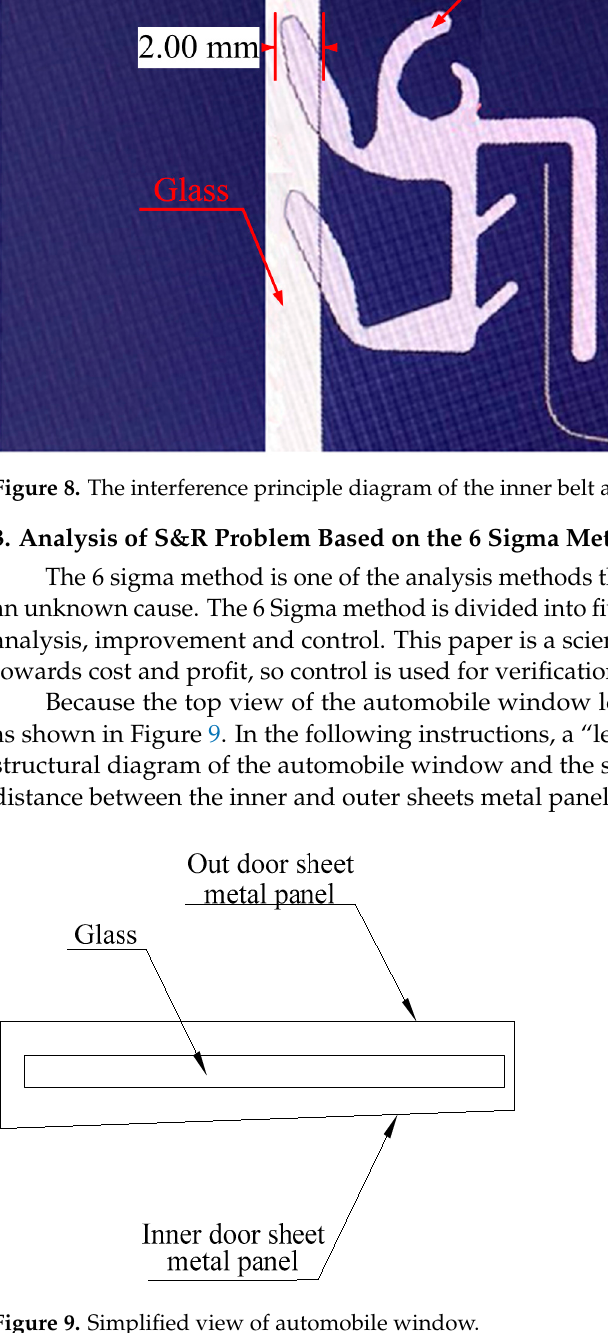
Figure 7. Motor and transmission mechanism. The movement of the experimental glass is driven by the mechanism.